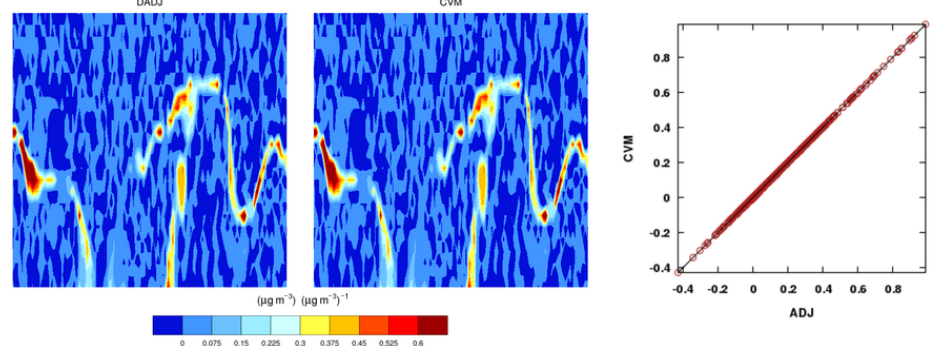
Figure 11. Evaluation of horizontal advection in the x direction with the DADJ (discrete adjoint) against the CVM (complex variable method) sensitivities of the final concentrations of an accumulation-mode aerosol species ASO4J (µgm − 3 ) with respect to the initial ASO4J (µgm − 3 ) from a 1d test run. For the tile plots, the x and y axes represent the horizontal y direction and the vertical layers, respectively. The perturbation size for the CVM is 1.E-12.